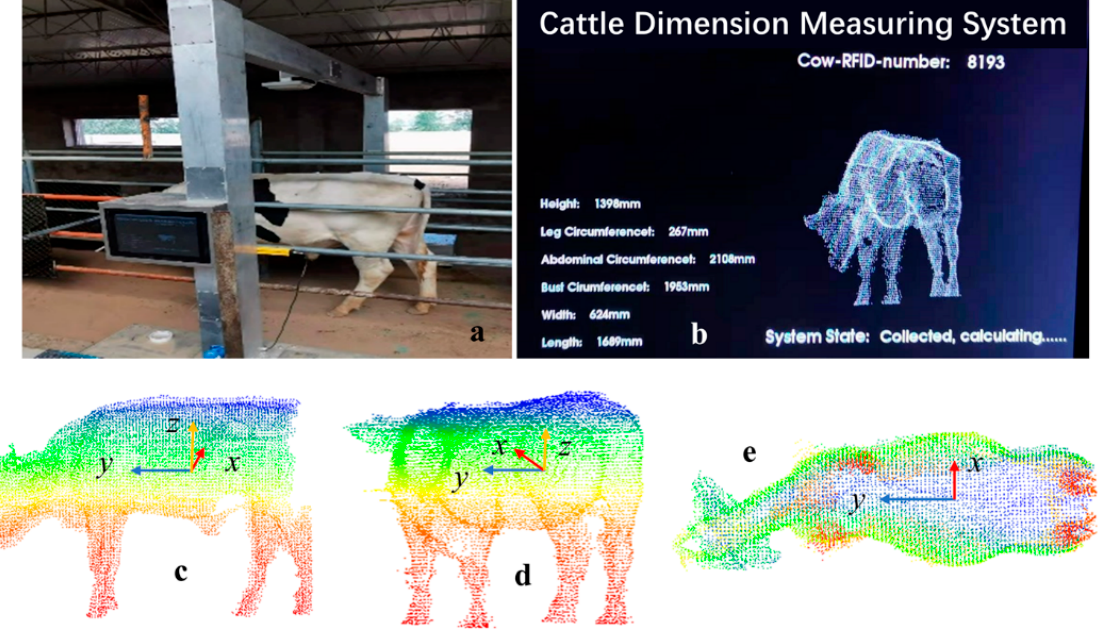
Figure 1. Beef cattle point cloud data acquisition equipment ( a ), user interface ( b ), and examples of collected point cloud data (front view ( c , d ), top view ( e )).